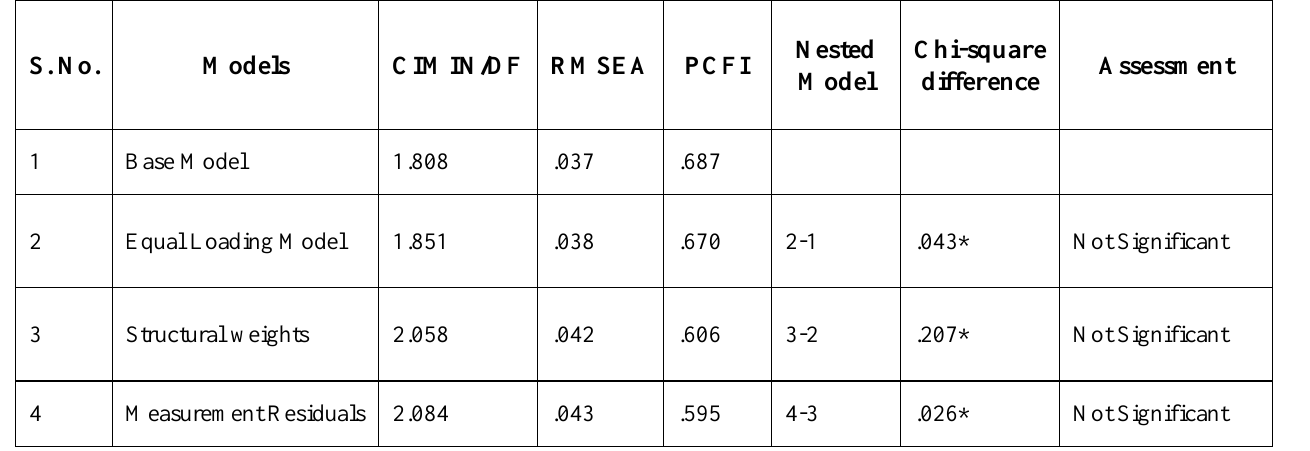
Table 04: Models Measuring Invariances across Three Samples S.